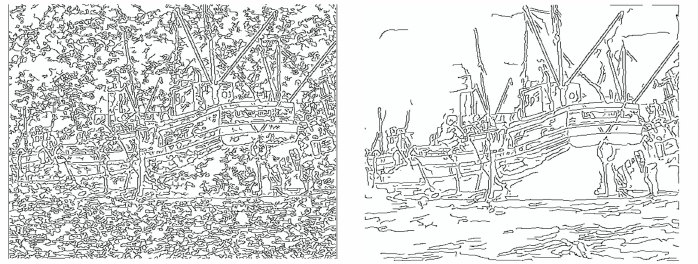
Figure 4. Comparison of Canny’s detector applied directly to noisy image ( left ) and proposed edge detection method ( right )— σ n = 30.